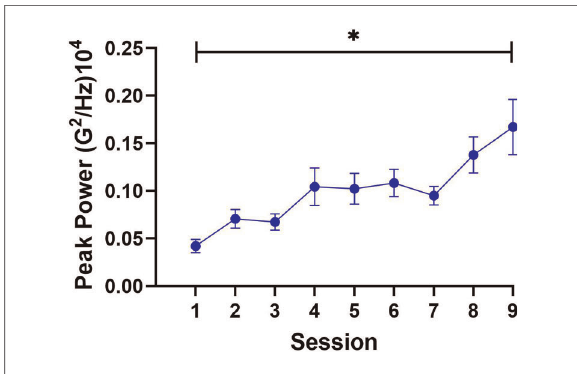
FIGURE 2 The fi ndings for peak power. Peak power was greater in Session 9 compared to Session 1 , which supports the effectiveness of the intervention. Note: Error bars denote standard error of the mean, *=signi fi cance at